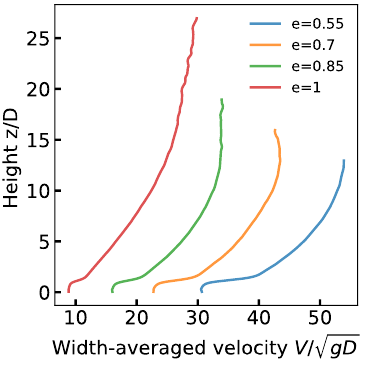
Figure 6: Vertical velocity profiles for decreasing restitu- tion coe  cient. The inclination angle is ✓ = 40  and the particle hold-up is H = 5 D .